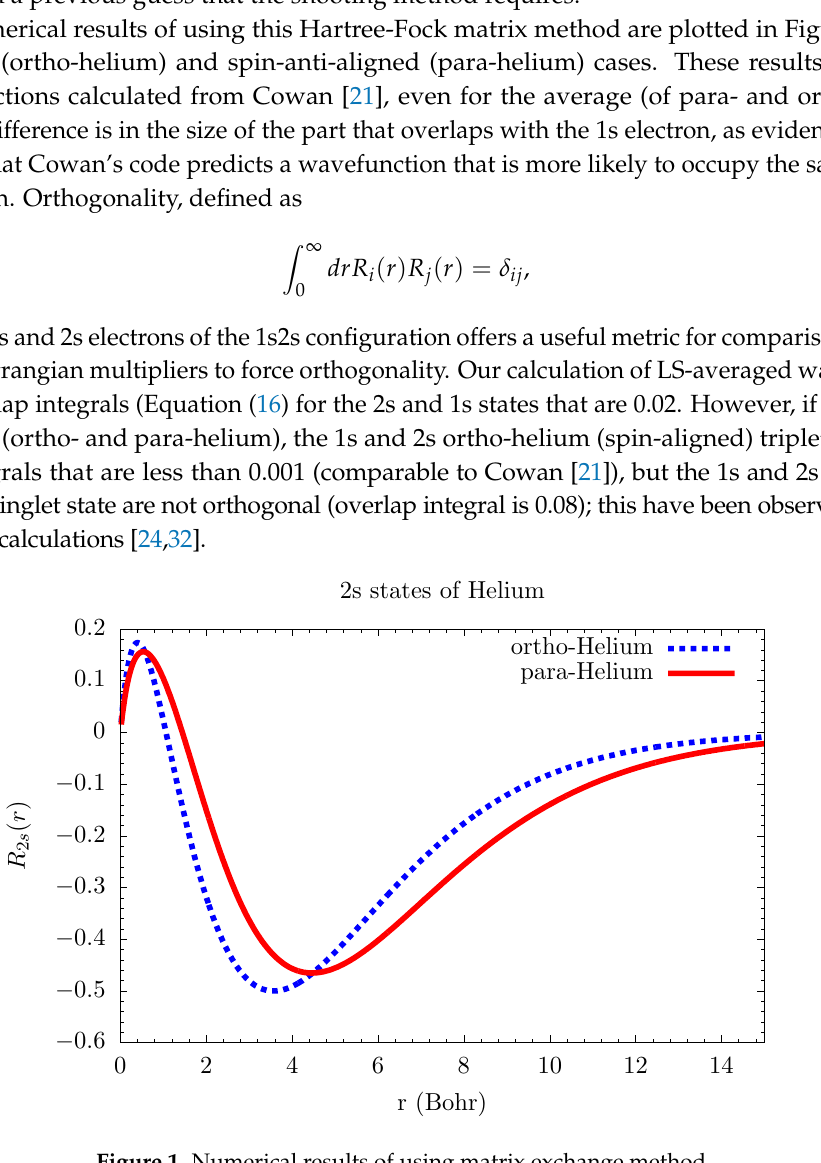
Figure 1. Numerical results of using matrix exchange method.